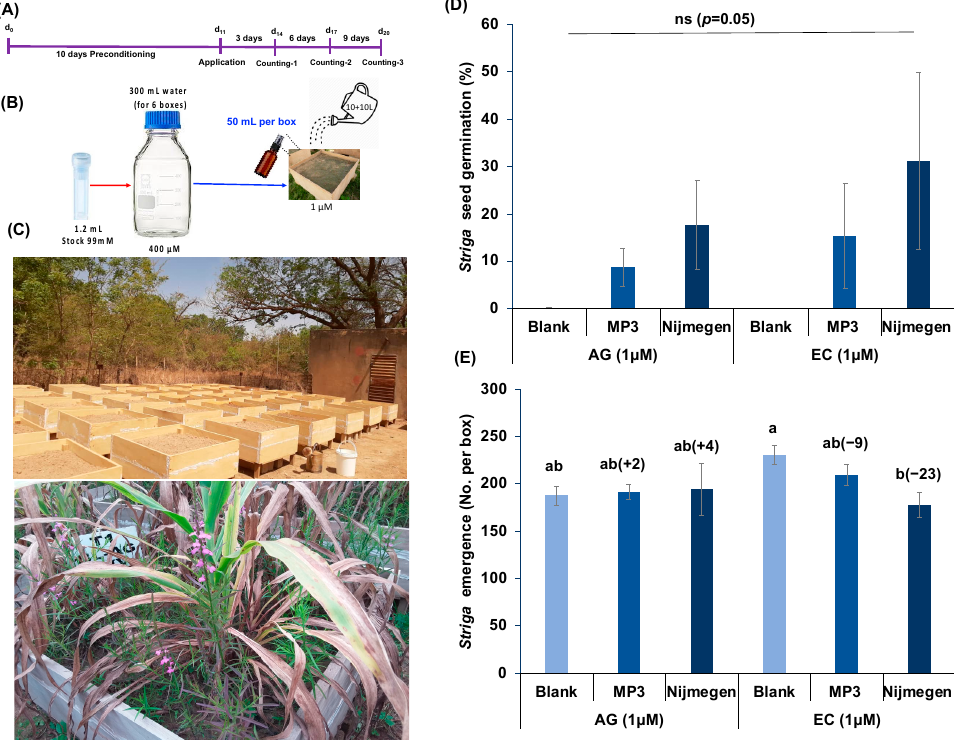
Figure 6. Effect of various formulations of SL analogs on Striga infection under mini-field conditions at Burkina Faso. ( A ) Scheme of the experiment conducted for Striga germination and emergence. ( B ) Experimental protocol adopted to conduct mini-field trials. Each box was filled with the soil, infested with Striga seeds collected from a pearl millet field in Burkina Faso. ( C ) View of the miniboxes and Striga infestation. ( D ) Average number of Striga seed germination in response to formulated MP3 and Nijmegen application. Both SL analogs of EC and AG formulations (at 1.0 µM) were applied in Striga infested mini-boxes. Striga germination was counted at 6 and 9 days after application. ( E ) Average number of Striga emergence in response to formulated MP3 and Nijmegen application. Striga emergence was counted after 80 days of pearl millet planting. Values of each bar showed average of Striga germination/emergence per minibox. Data are means ± SE ( n = 6). For each SL analog, treatments with various letters differ significantly ( p < 0.05). Values in parenthesis are showing the percentage increase (+) or decrease ( − ) over blank treatment. ns: non-significant.